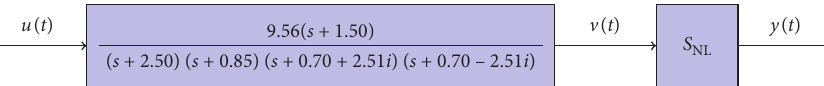
Figure 9: Numerical example 1: Wiener structure.